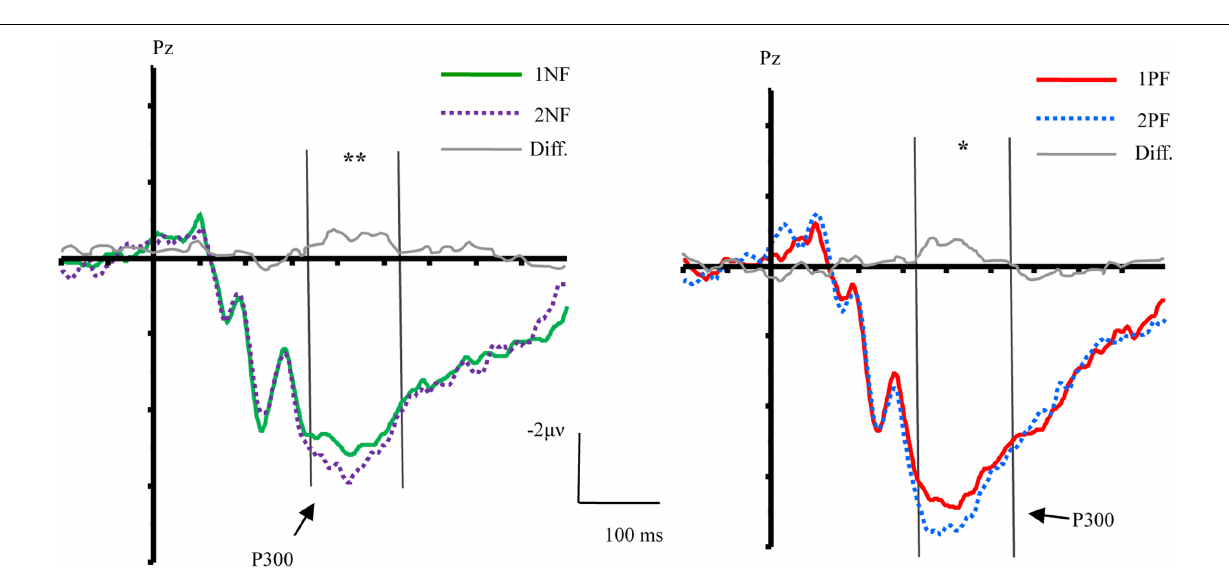
= 0.35] were observed. p = 0.37], p = 0.26] were observed. p